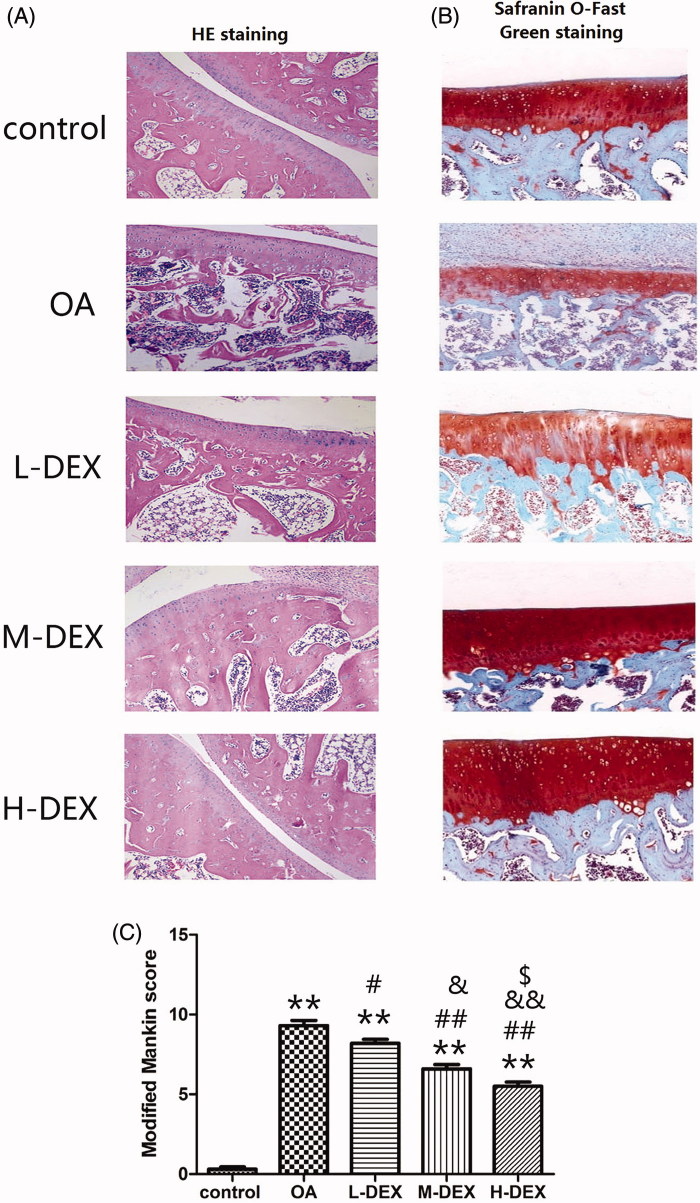
Effect of Dex on the morphological structure of articular cartilage in OA rats. After Dex treatment was completed, HE staining (A, ×100) and Safranin O staining (B, ×200) were used to analyze the morphological structure of cartilage tissue of OA rats. (C) Quantitative analysis of cartilage lesions in OA rats using a modified Mankin score. Values are means ± SD. N = 10. **p < 0.01 vs. control group; #p < 0.05, ##p < 0.01 vs. OA group; &p < 0.05, &&p < 0.01 vs. L-DEX group; $p < 0.05 vs. M-DEX group.